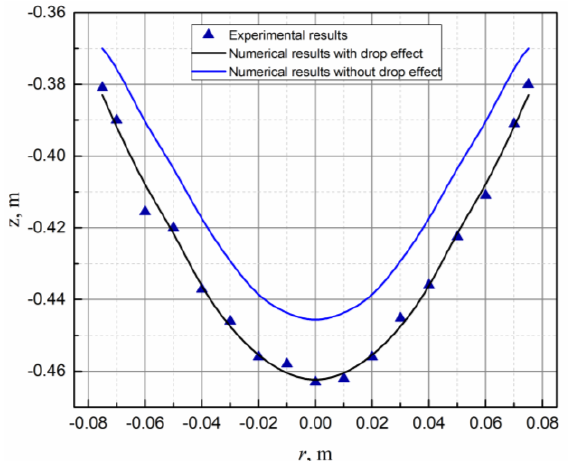
Figure 21. Comparison of molten metal pool structure between the experimental value and the numerical value.